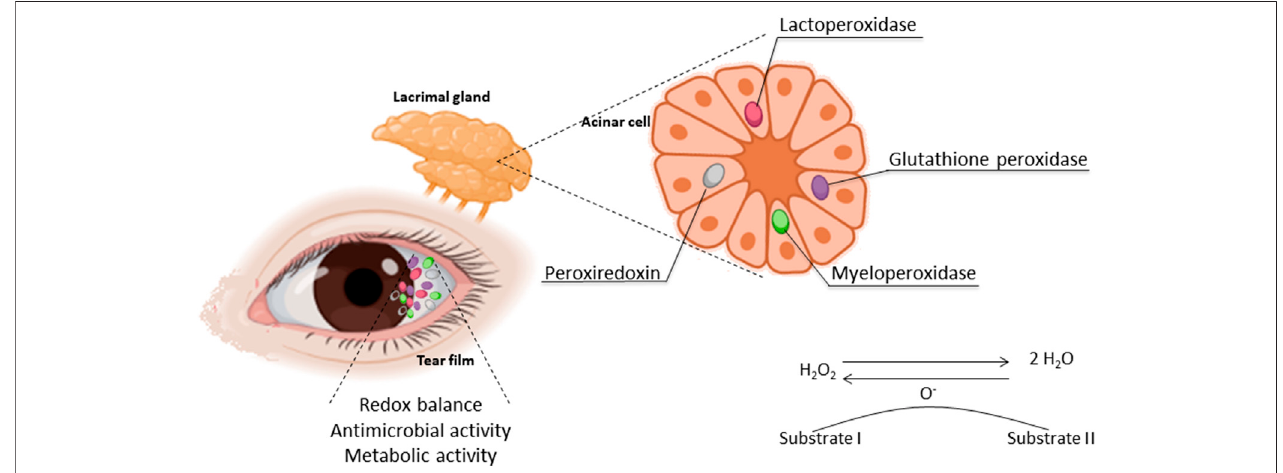
FIGURE 1 | Oxidative stress in the LFU: the sources and area where the antioxidant enzymes take place and their activity.